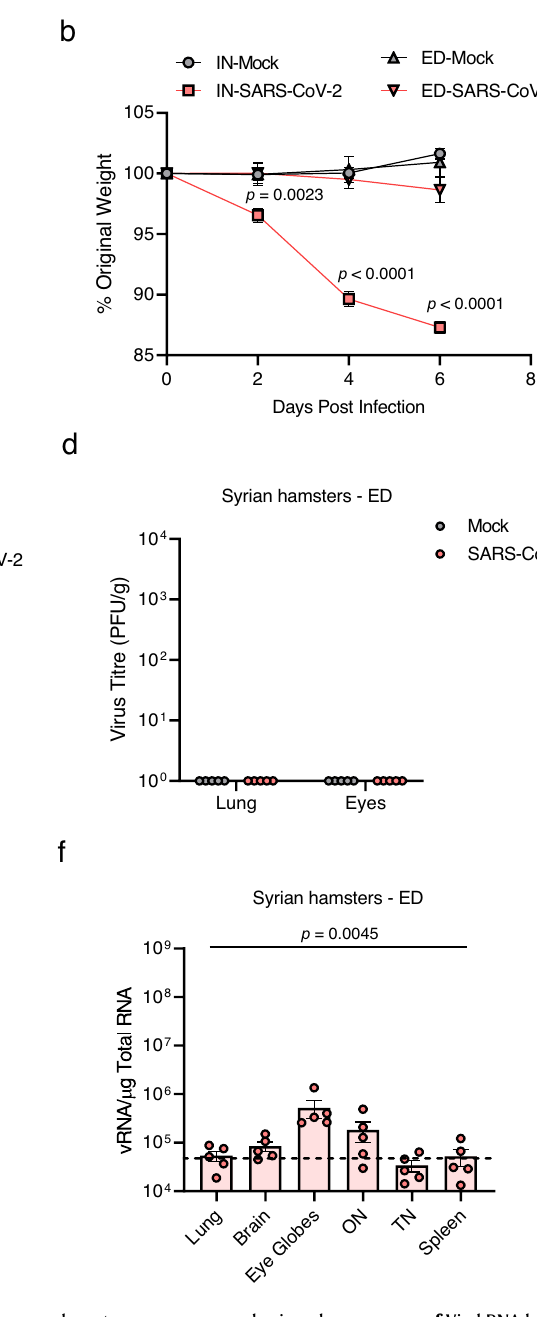
hamsters were measured using plaque assay. e , f Viral RNA levels at 6 dpi in the lungs,brain,eyeglobes,opticnerves(ONs),trigeminalnerves(TNs)andspleensof IN-infected ( e )and ED-infected( f )animalswereassessedusingRT-qPCR.ViralRNA copies were subjected to a cut-off at 10 4 copies/ μ g. The dashed line indicates the viral RNA levels of the spleen as a limit of detection. Symbols represent means± SEMs. Statistically signi fi cant differences between the groups were determined using multiple two-tailed t-tests ( a, b ), unpaired two-tailed t -test ( c, d ), or one-way ANOVA ( e, f ). SARS-CoV-2 severe acute respiratory syndrome coronavirus 2, PFU plaque-forming unit, dpi days